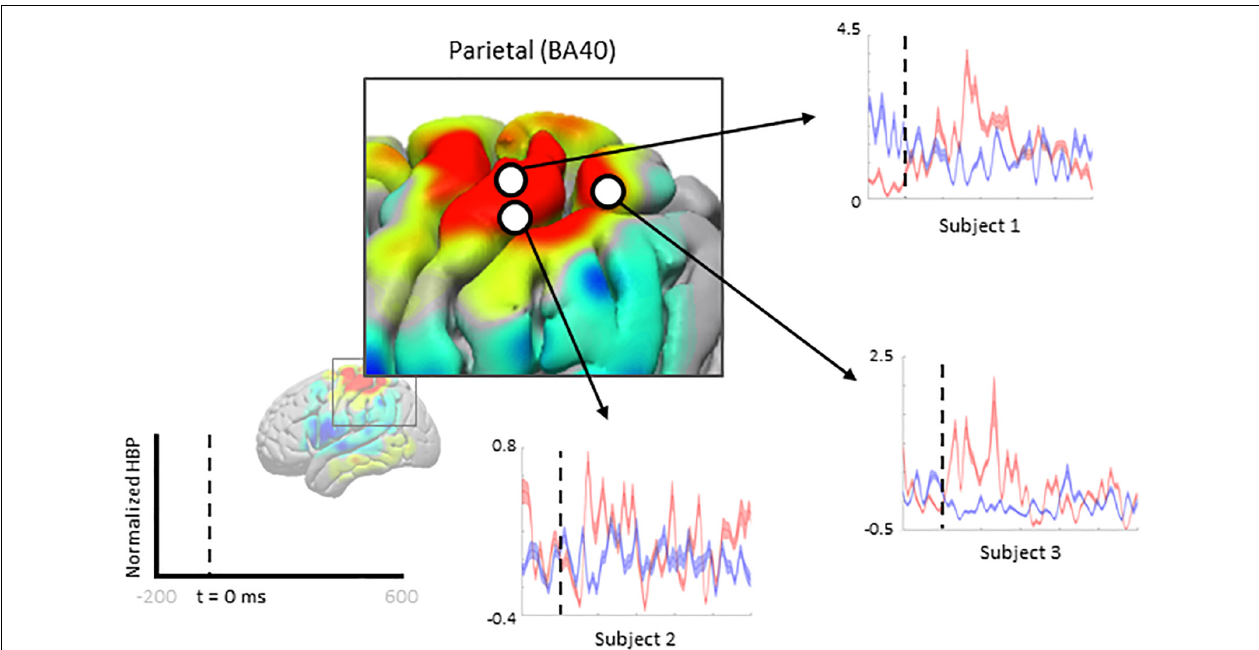
FIGURE 7 | Increased HBP in multiple cortical areas during motor imagery error (parietal). Each plot shows the average response of a single electrode (from one subject, each) within Brodmann Area 40 during erroneous decoding (red) and during correct decoding